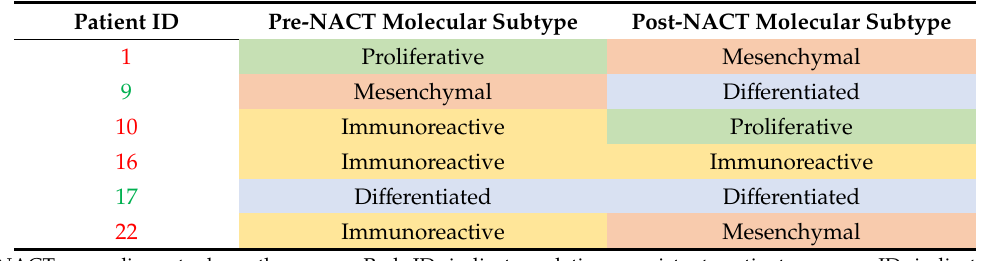
Table 2. Molecular subtype